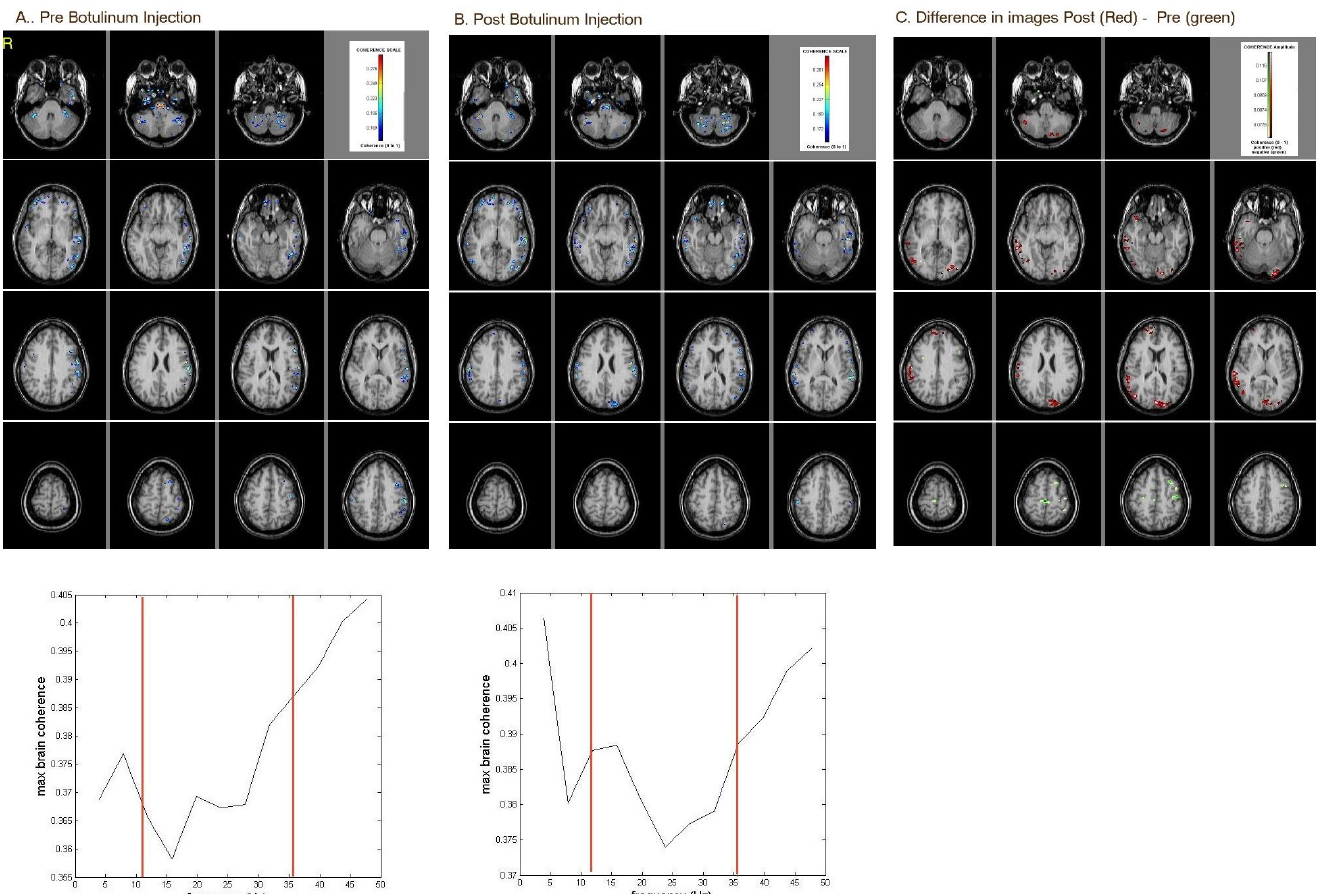
Figure 2. MEG-CSI results of resting-state brain-coherence activity ( A ) pre-botulinum injection; ( B ) post-botulinum injection; ( C ) subtraction of both images showing post-botulinum injection (red) minus pre-botulinum injection (green) differences. Prior to botulinum injection, areas in the superior partial and left parietal were active. After botulinum injection, areas in the occipital and right temporal were more active.